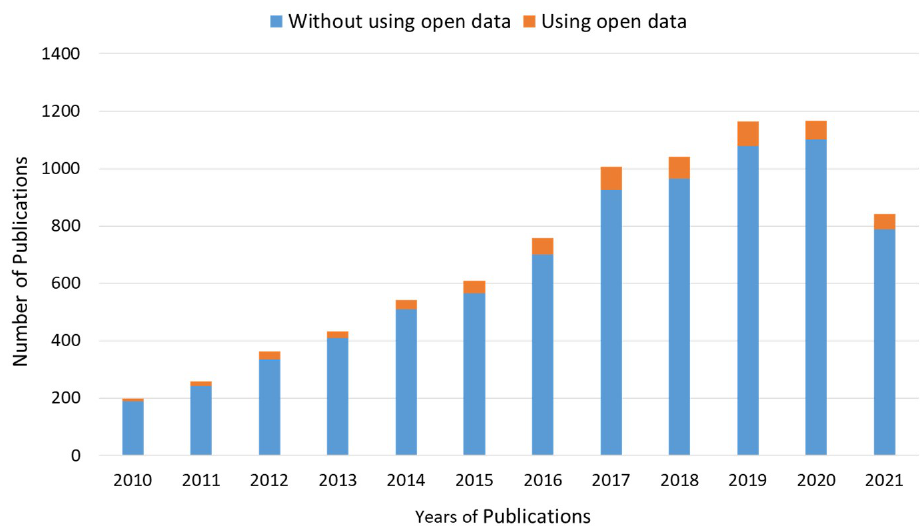
Figure 3. Publication trend from 2010 to 2021 for Urban Building Energy Modelling-based studies with and without using open data based on the World of Science [119] academic search